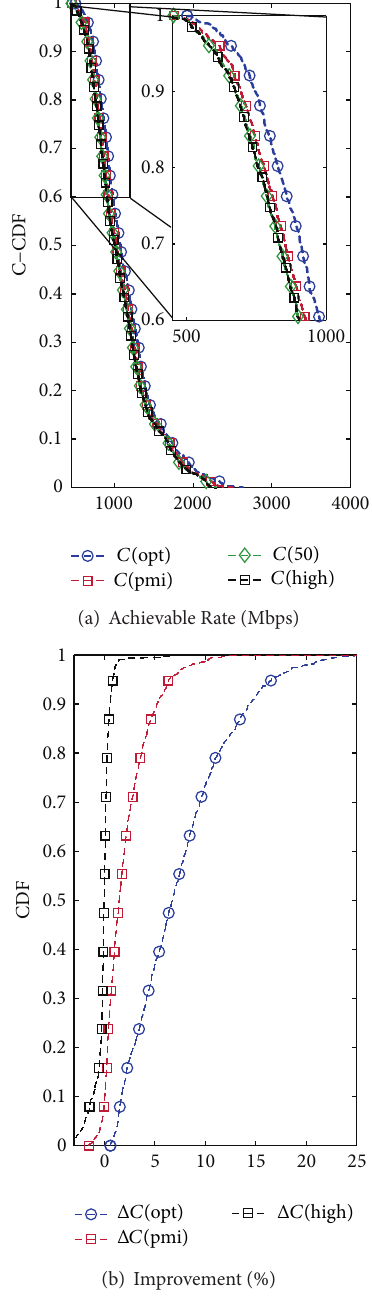
Figure 9: (a) C-CDF of the achievable rate when the receiver impedance is optimal, matched in power or constant and equal to 50 Ω or 1k Ω . (b) CDF of the achievable rate improvement with respect to the case of 𝑍 50